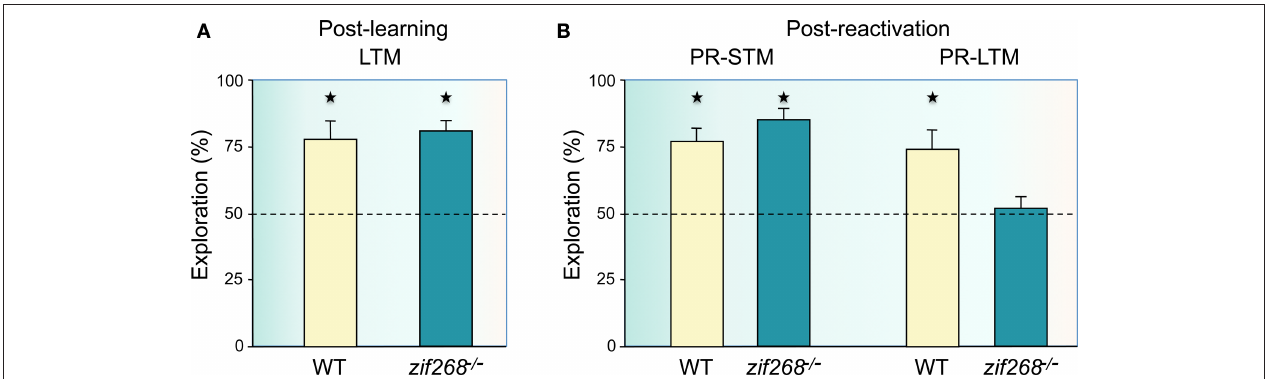
training, post-reactivation short-term memory (PR-STM) was intact (left panel). FiguRe 2 | Reconsolidation of spatial object-place recognition memory is Both WT and zif268 mutant mice preferentially explored the displaced object impaired in zif268 mutant mice. (A) The mice were exposed to a spatial ( p < 0.05 in each case), with no significant difference between groups ( F = 1.74; configuration of two objects for eight consecutive sessions (overtraining) on day 1 1,8 p > 0.05). In contrast, post-reactivation long-term memory (PR-LTM) was impaired to alleviate their consolidation deficit and retention was tested 2 days later. In this in zif268 mutant mice (right panel). While WT mice preferentially explored the condition, zif268 mutant mice had normal object-place recognition long-term displaced object ( n = 5; p < 0.05), performance of zif268 mutant mice was not memory (LTM) as they showed preferential exploration of the displaced object different from chance ( n = 5; p > 0.05) and there was significant difference ( n = 5; p < 0.05) as WT mice ( n = 5; p < 0.05), with no significant difference between groups ( F = 6.52; p < 0.05). Ordinates: percent time spent exploring between WT and mutant mice ( F = 0.12; p > 0.05). (B) When zif268 mutant 1,8 1,8 the displaced object over the time spent exploring the non-displaced mice were briefly re-exposed to the familiar configuration of objects 24 h after